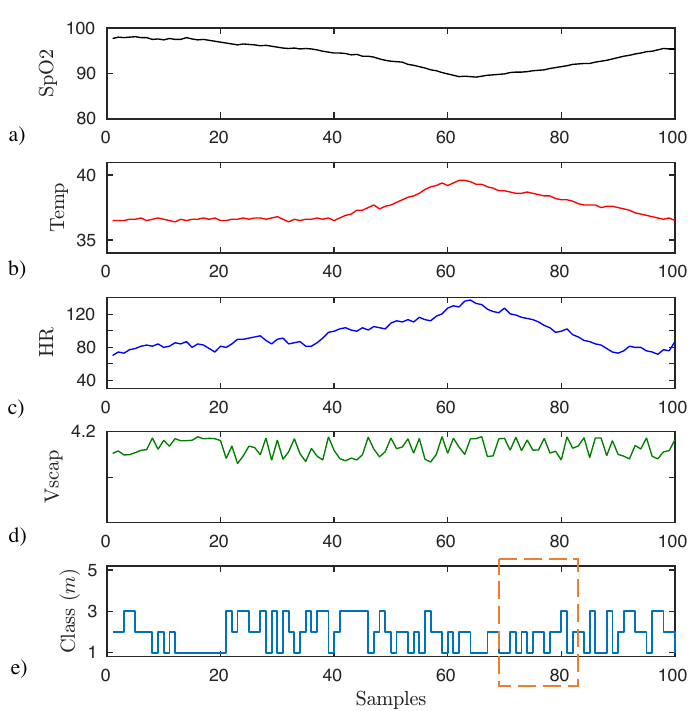
Figure 8. ML-decision tree results for test case scenario 1: ( a – c ) SpO2, Temperature and Heart rate measurements; ( d ) Supercapacitor’s voltage; and ( e ) ML-decision tree classification